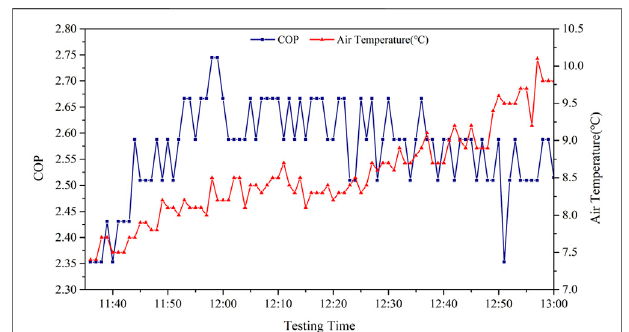
FIGURE 10 | The COP and outdoor air temperature in condition 5.